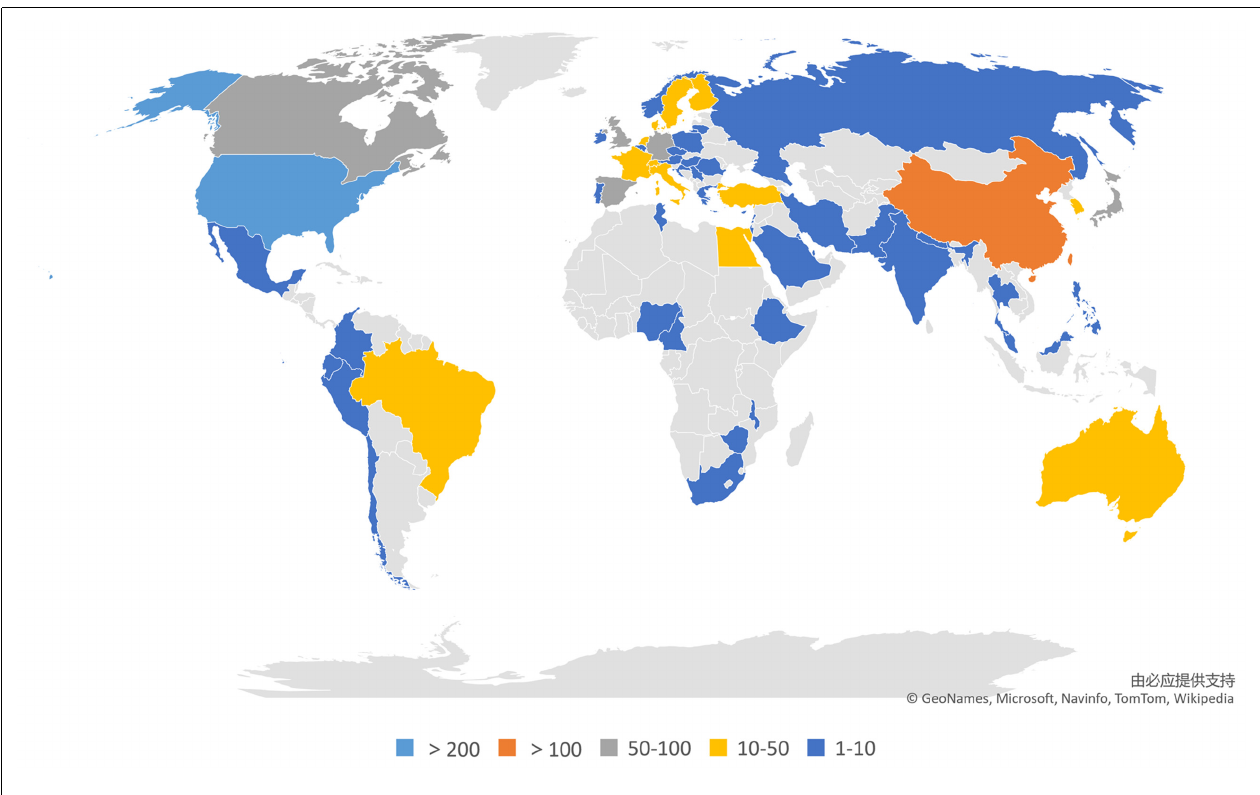
FIGURE 7 | World map of total country output based on NP associated with anxiety or depression research.